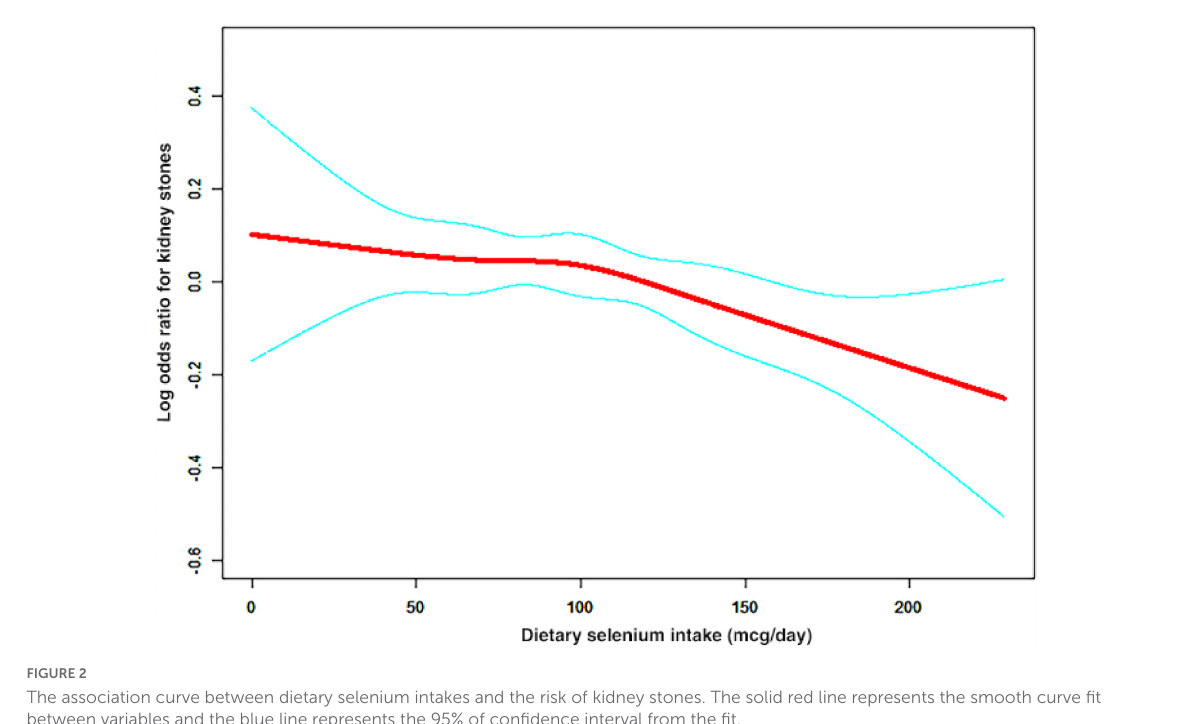
FIGURE2 The association curve between dietary selenium intakes and the risk of kidney stones. The solid red line represents the smooth curve fit between variables and the blue line represents the 95% of confidence interval from the fit.